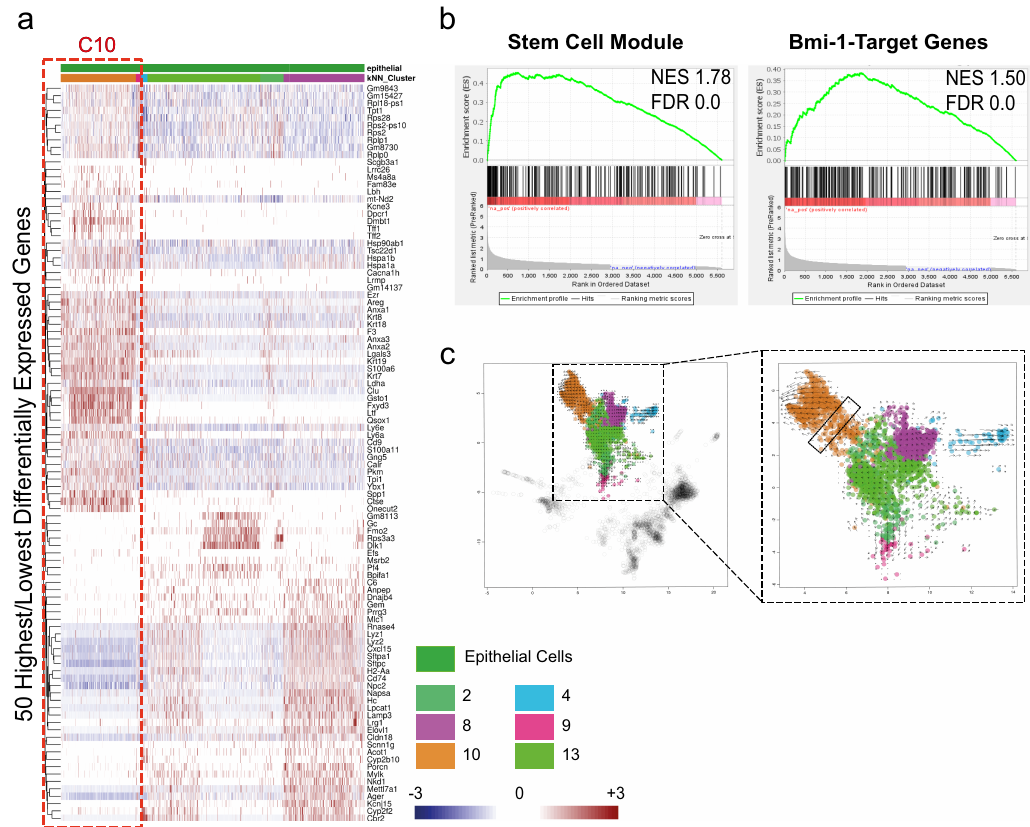
Fig. 3 The transformed epithelial tumor-speci fi c cluster shows a de fi ned signature. a Heatmap showing the 50 highest and lowest expressed genes in C10. b GSEA shows enrichment of stem cell module genes (FDR = 0.0) and Bmi-1 target genes (FDR = 0.0) in C10, as compared with all other tumor epithelial clusters. Normalized enrichment score (NES) is indicated in each panel. c RNA velocity analysis recapitulates dynamics of tumor epithelial cells (zoomed in the dotted box) differentiation. Within the dotted box short/no arrow-containing cells indicate the point of origin from which other C10 (orange) tumor cells are